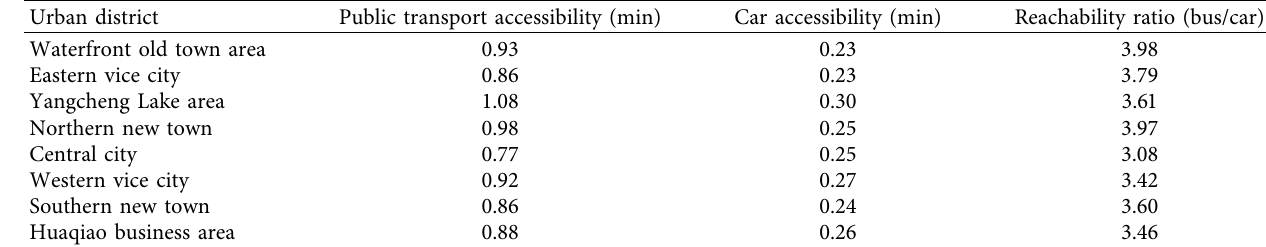
Table 6: Comparison of accessibility values by zone.